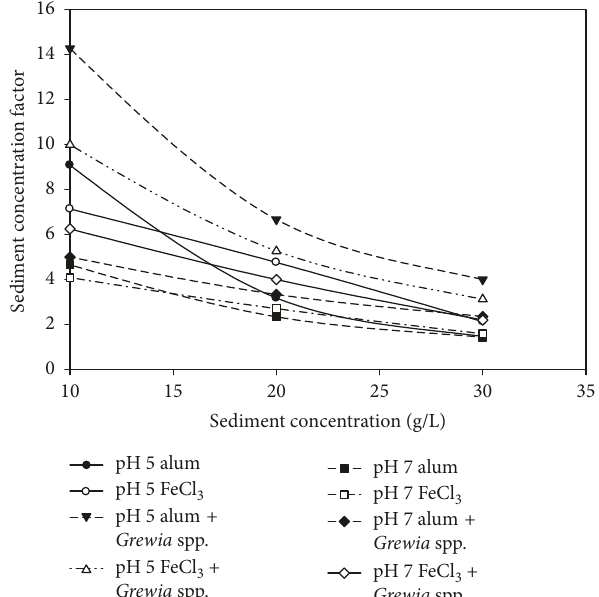
Figure 9: Sediment concentration factor vs. concentration of laterite